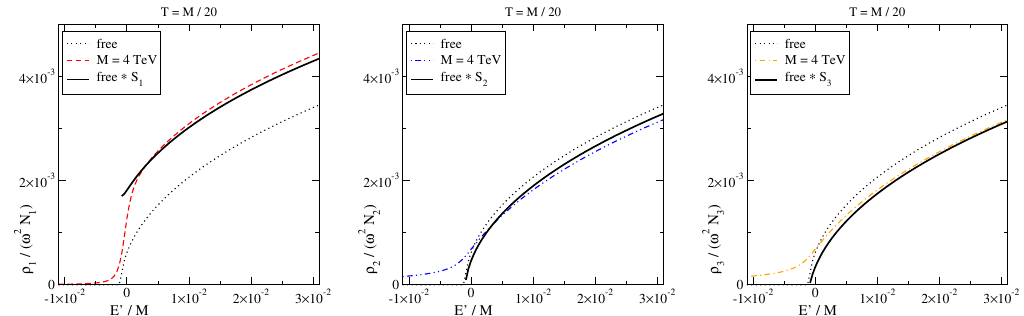
Figure 3 . The free (dotted lines; shifted by the Salpeter correction) and resummed (coloured lines; cf. eq. (4.8)) spectral functions for M = 4 TeV, T = M= 20, compared with results predicted by the massless Sommerfeld factors (solid lines; cf. eq. (A.16)). The potentials are from eqs. (4.17){(4.19); V is attractive and V are repulsive at short distances ( V is attractive at large distances). The 1 2 ; 3 2 spectral function (cid:26) obtains a more dramatic shape at low temperatures, cf. (cid:12)gure 6(left). 1 g 2 ((cid:22) (cid:22) ) (cid:25) 48 (cid:25) 2 = [41 ln((cid:3) = (cid:22) (cid:22) )] and g 2 ((cid:22) (cid:22) ) (cid:25) 48 (cid:25) 2 = [19 ln((cid:22) (cid:22)= (cid:3) )]. For (cid:22) (cid:22) > M we switch to the 1 1 2 2 IDM evolution [56], g 2 ((cid:22) (cid:22) ) (cid:25) 48 (cid:25) 2 = [42 ln((cid:3) 0 = (cid:22) (cid:22) )] and g 2 ((cid:22) (cid:22) ) (cid:25) 48 (cid:25) 2 = [18 ln((cid:22) (cid:22)= (cid:3) 0 1 1 2 2